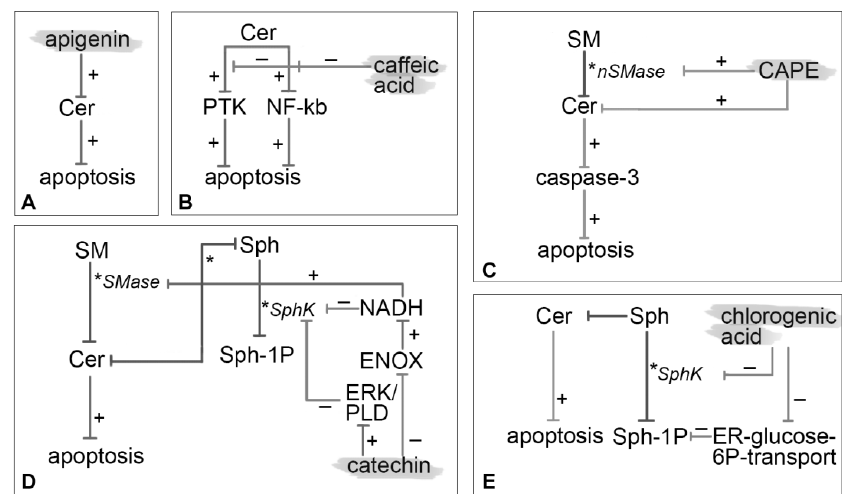
Figure 3. Mechanism of modulation on sphingolipids by apigenin ( A ), caffeic acid ( B ), CAPE ( C ), catechin ( D ) and chlorogenic acid ( E ). It is depicted with an asterisk (*) enzymatic pathway, with plus (+) red-regulated pathway and with minus (−) down-regulation ones. PTK: protein tyrosine kinase.